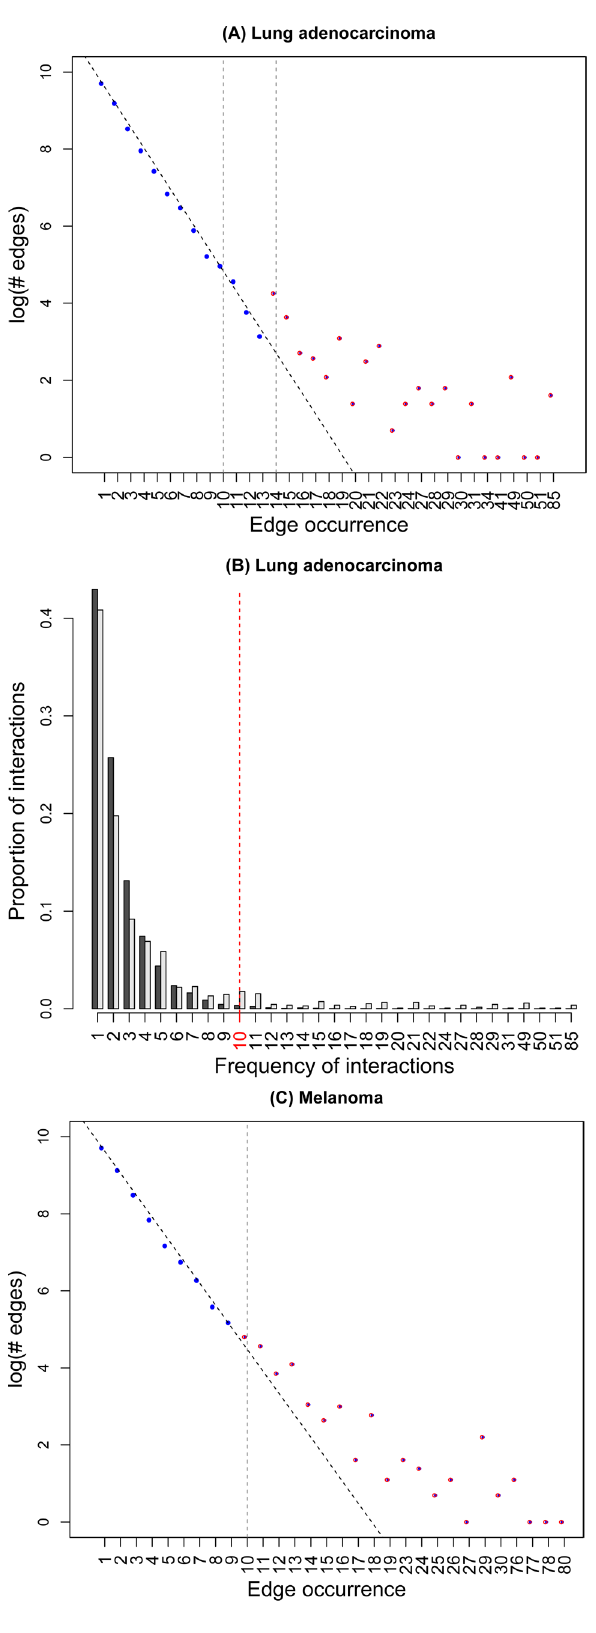
Figure 3. Distribution of significant interaction frequency. (A) Distribution of the number of edges (in a logarithmic scale) versus their occurrence in LUAD. The vertical line at 14 indicates the threshold